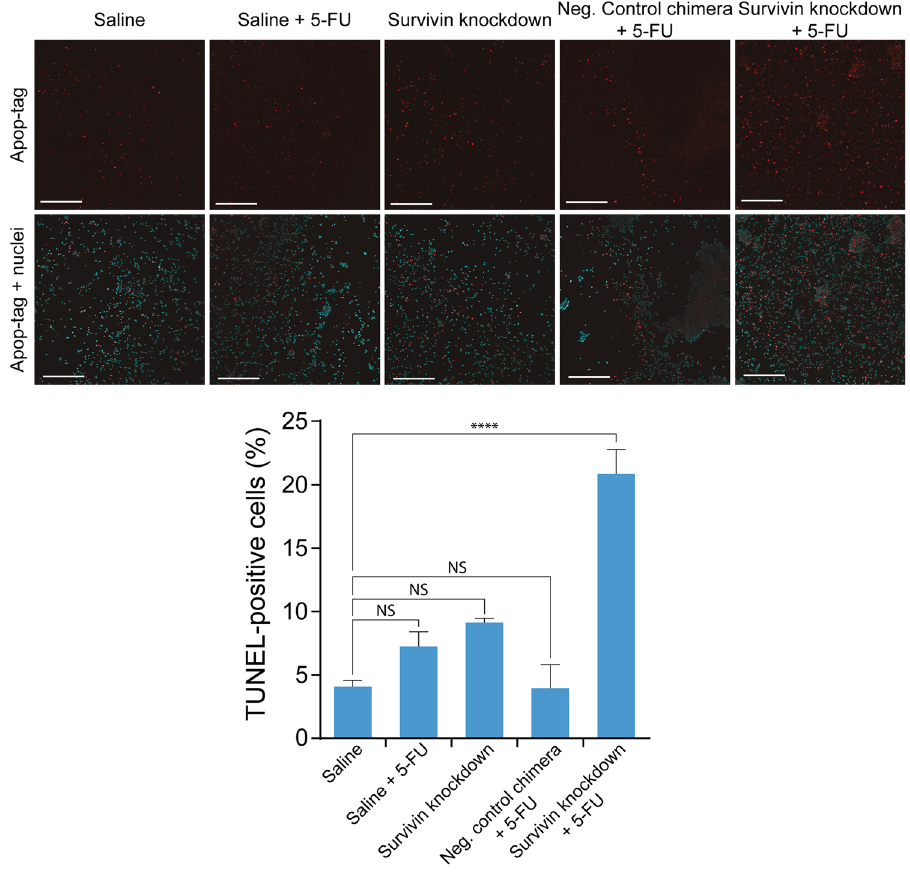
Figure 3. Survivin knockdown in vivo enhances 5-FU-induced apoptosis in HT-29 tumour cells. ( a ) Representative images of TUNEL apoptosis assay on dissociated HT-29 xenograft tumours after in vivo treatment with chimera and 5-FU. NOD/SCID mice bearing HT-29 tumours (60 mm 3 ) were treated intravenously with 3 injections of 2 nmol/mouse of chimera with or without 3 additional treatment of 30 mg/ kg of 5-FU. Two days after the final treatment, tumours were dissociated by collagenase digestion and subjected to TUNEL apoptosis assay. ( b ) Percentage of apoptotic cells in treated tumours. Data shown are means ± SEM, n = 3. **** p < 0.001. NS, no statistically significant